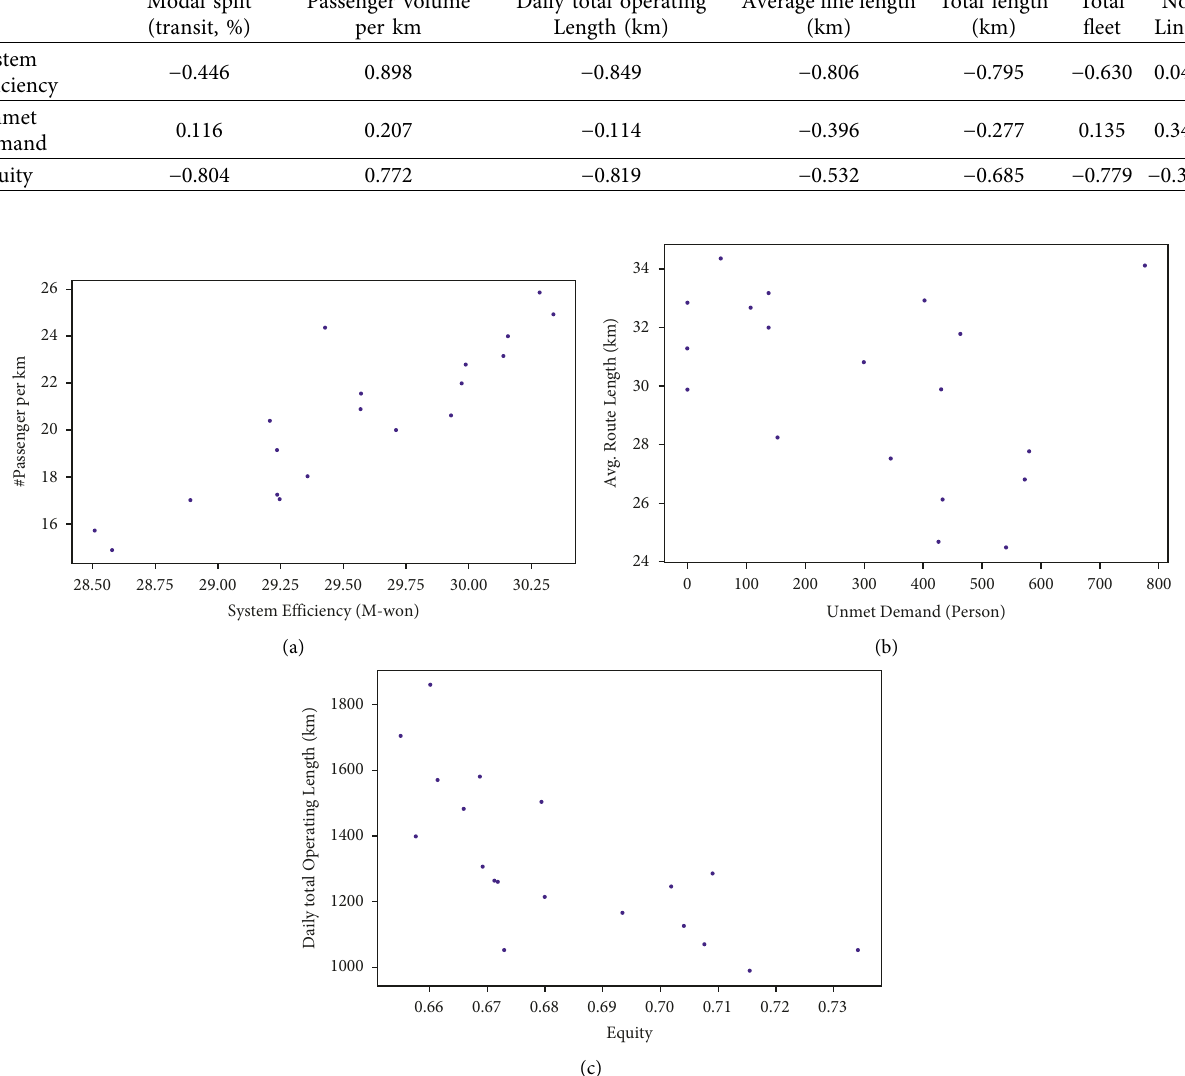
Figure 9: Changes in the objectives. (a) System efficiency. (b) Unmet demand. (c)